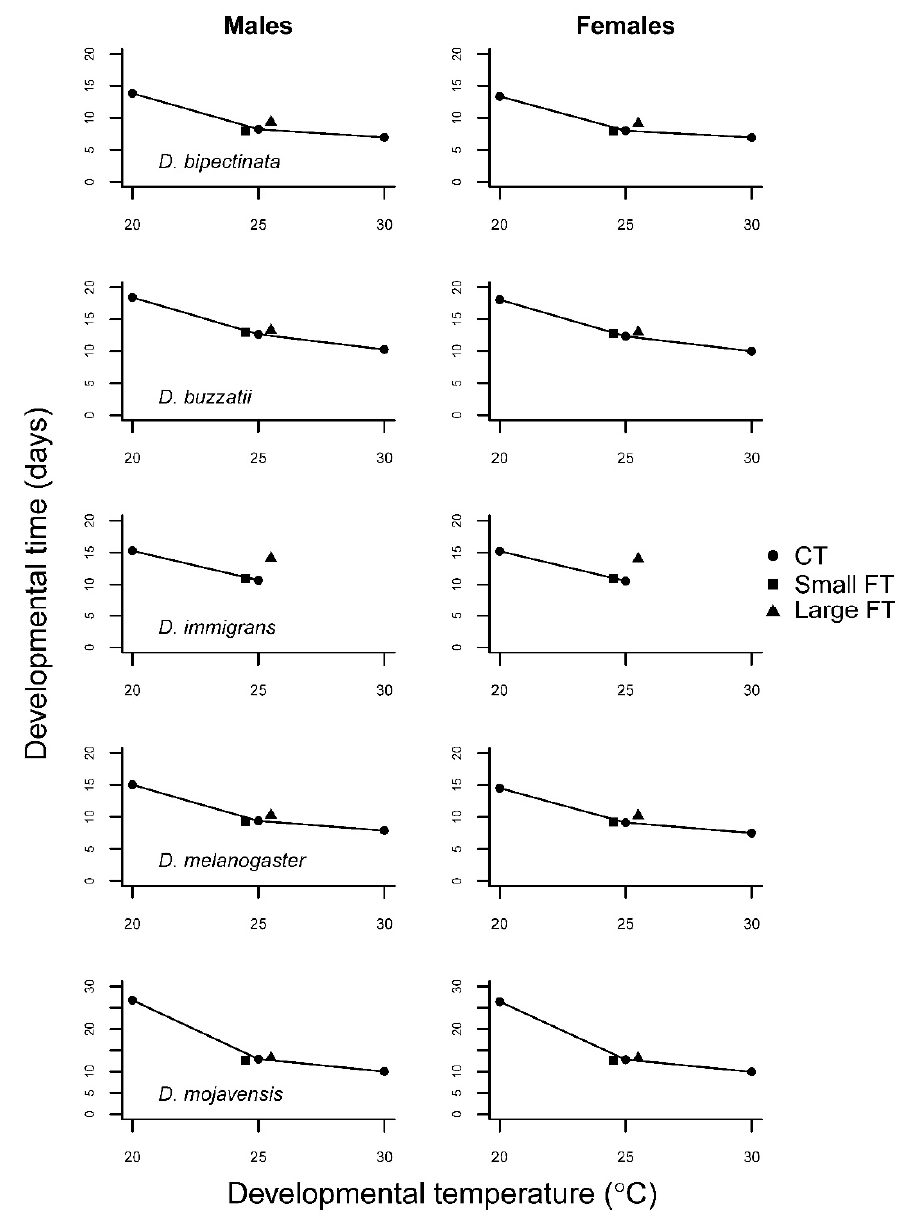
Figure 2. Mean developmental time in days as a function of developmental temperature regime in five Drosophila species. The error bars are not visible because they are hidden behind symbols.